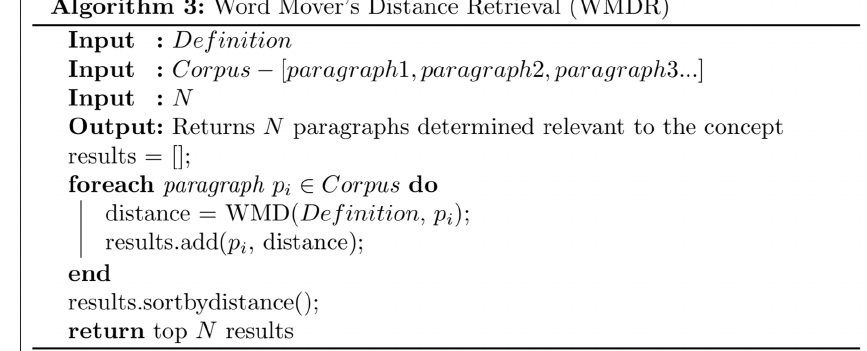
Figure 4: WMD Retrieval